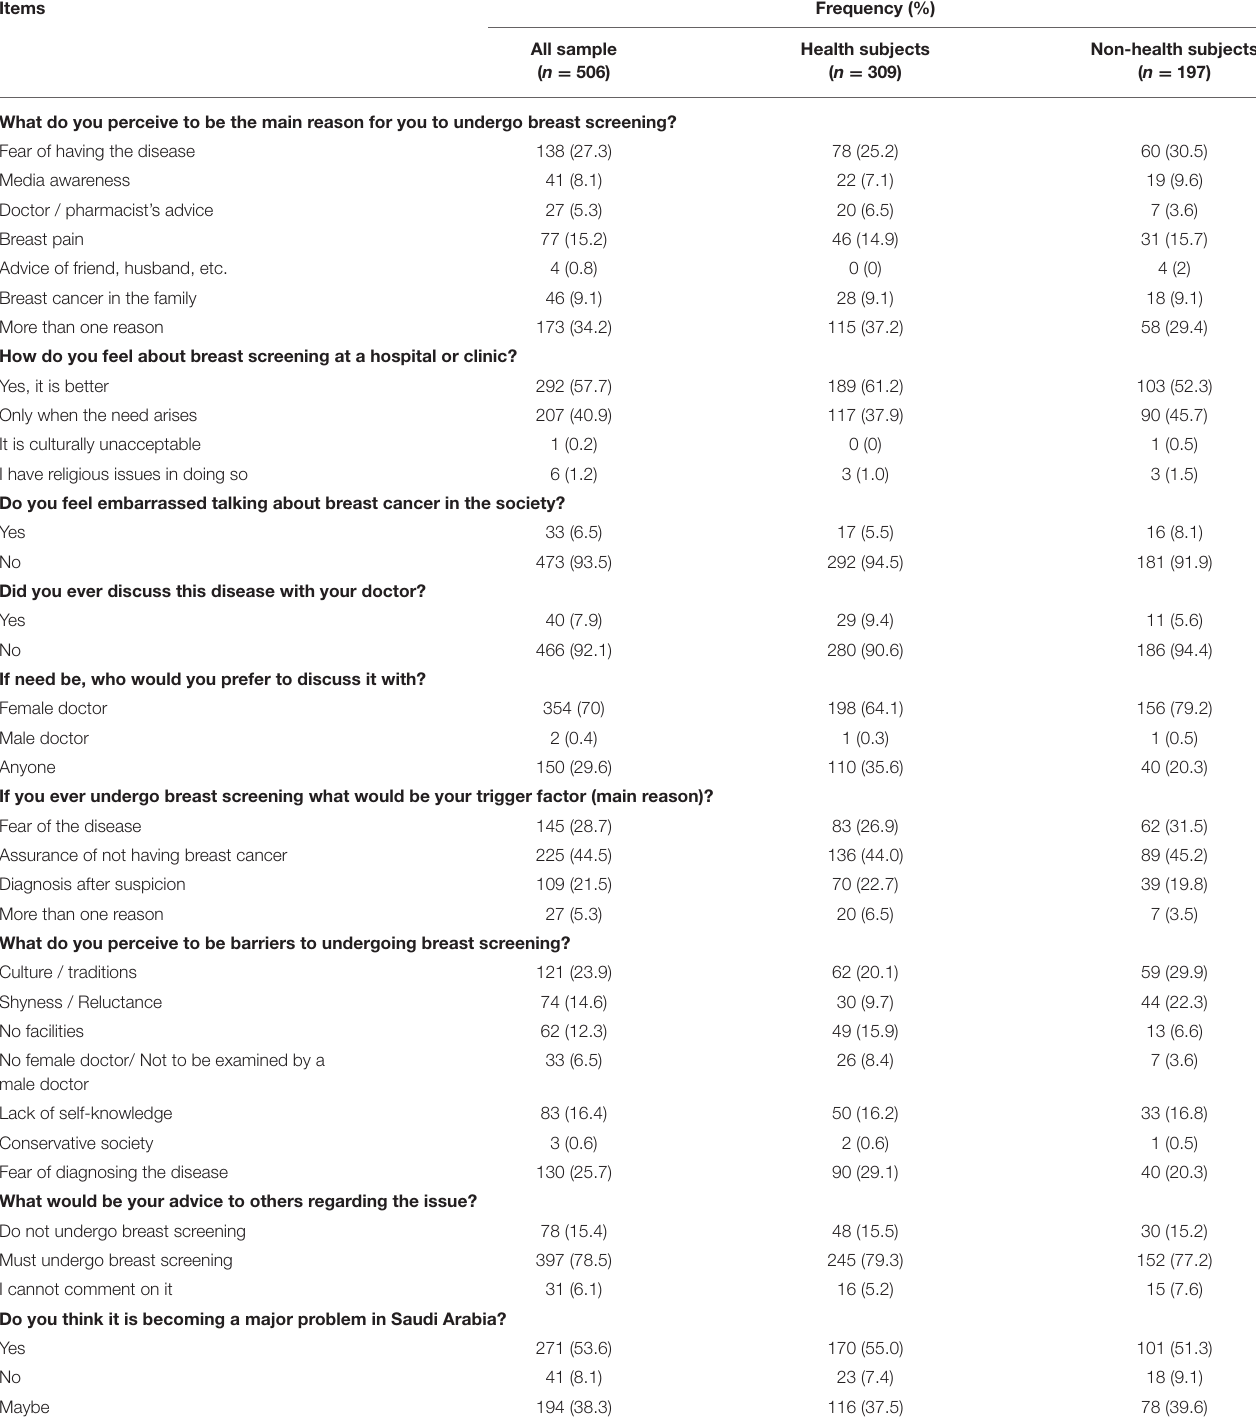
TABLE 3 | Attitudes of students toward BC ( N =